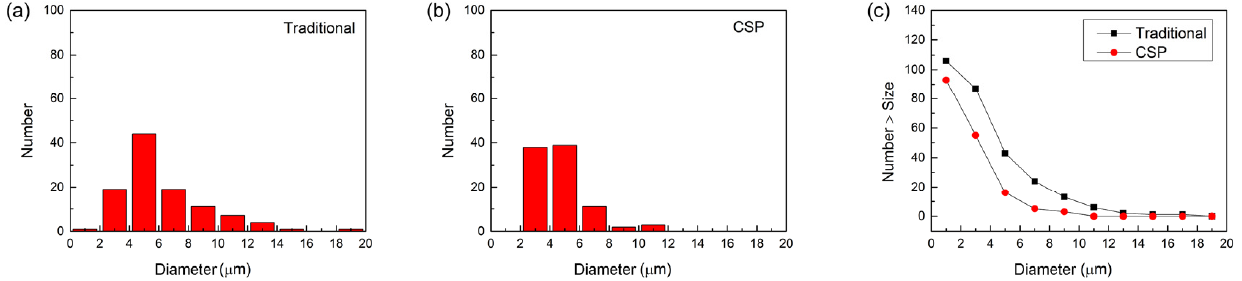
Figure 9. Statistics histograms of Al 2 O 3 /Al inclusions of ( a ) traditional process ( b ) CSP process, and ( c ) the cumulative distribution for the Al 2 O 3 /Al inclusions in two processes.